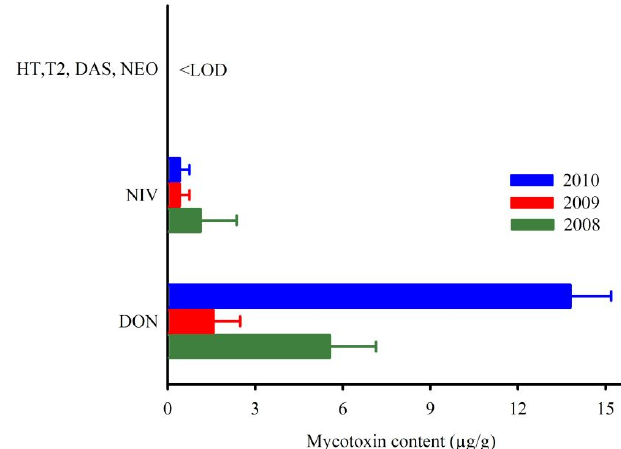
Tab. 2: Isolation frequency of F. graminearum from naturally infected wheat kernels